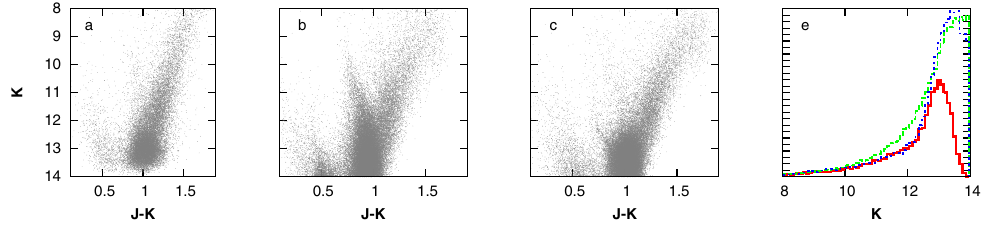
Figure 2. Colour-magnitude diagrams for the 2MASS field at l = 0, b = − 4. (a) data; (b) best fit model with 1 ellipsoid; (c) best fit model with 2 populations; (d) histograms of data (solid red) and models (1 ellipsoid: long dashed green; 2 populations: dotted blue). The CMD and differential star counts are well reproduced by a 2-population model with a bar and a bulge. 2MASS data in this field are incomplete at K > 12.5. data over the minor axis of the bar, allowing to put constraints on the mean metallicity of the composite populations in the bulge